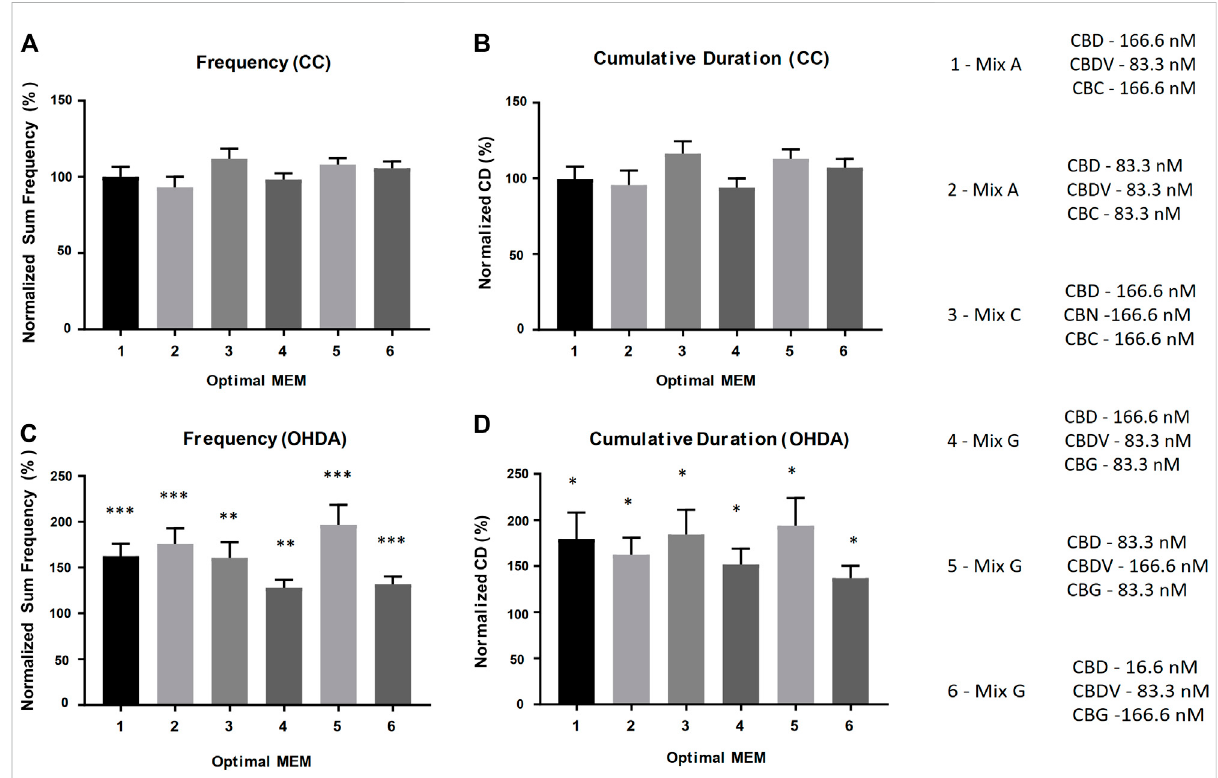
FIGURE 6 Optimal DCR-MEM ratios alleviate both OHDA mediated frequency and cumulative duration de fi cits. Activity metrics of Total Frequency (A – C) and Cumulative Duration (B – D) . Optimal DCR-MEM vs. methanol carrier control (A,B) , and Optimal DCR-MEM+150 µM OHDA vs. 150 µM OHDA (C,D) . * = p < 0.05, ** = p < 0.01, *** = p <